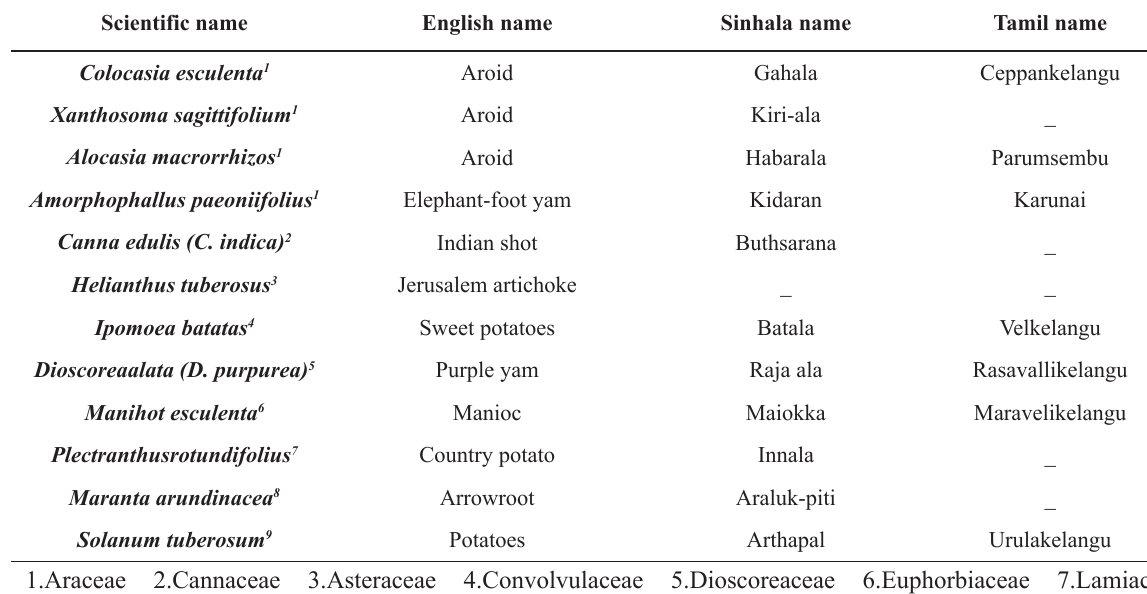
Table 3: Starchy roots and tubers consumed in Sri